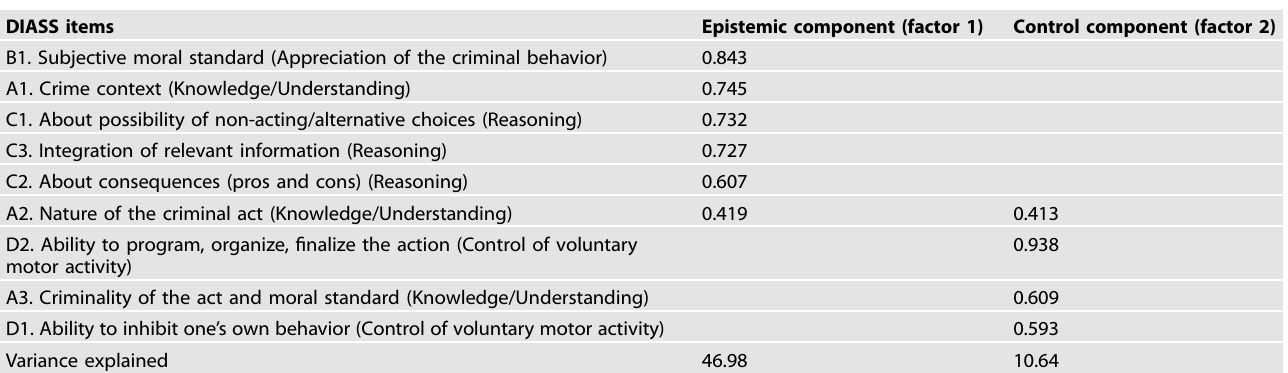
Table 4. DIASS principal component